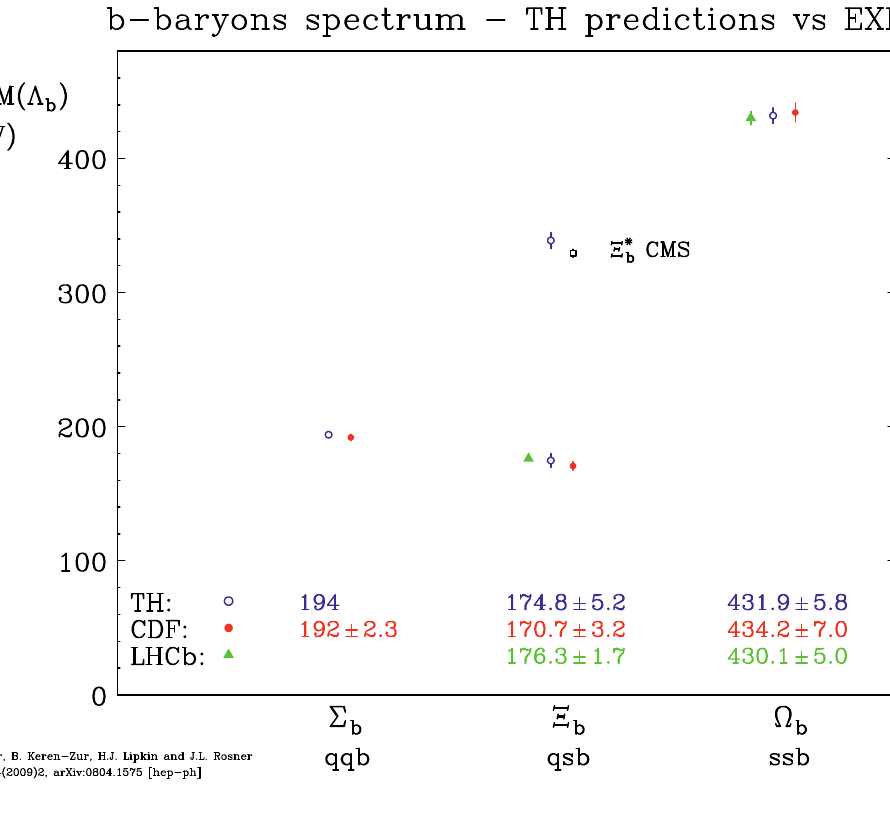
Figure 1. Masses of b -baryons – theoretical predictions [7, 13] vs.